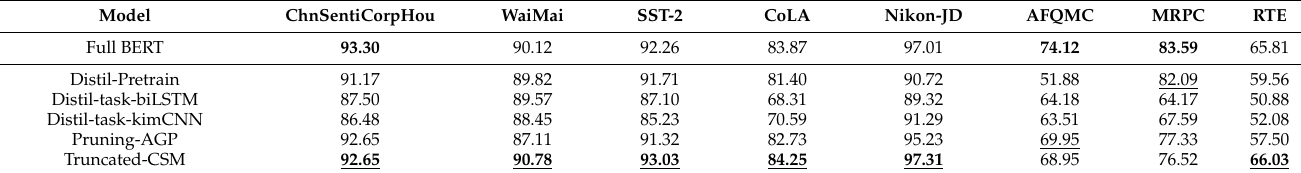
Figure 6. The test accuracy (left vertical axis) and number of Transformer layers preserved in the truncated model (right vertical axis) vary when 𝜌 changes from 0 to 1 with a stride of 0.05. The horizontal axis is the value of 𝜌 . Each subplot corresponds to a different dataset. The vertical dashed line in each subplot corresponds to 𝜌 = 0.20. Best viewed in color. Table 5. Test accuracy (%) on the 8 tasks in this article. Bolded values denote the highest among all models (i.e., including full BERT), and underlined values denote the best among compressed models.